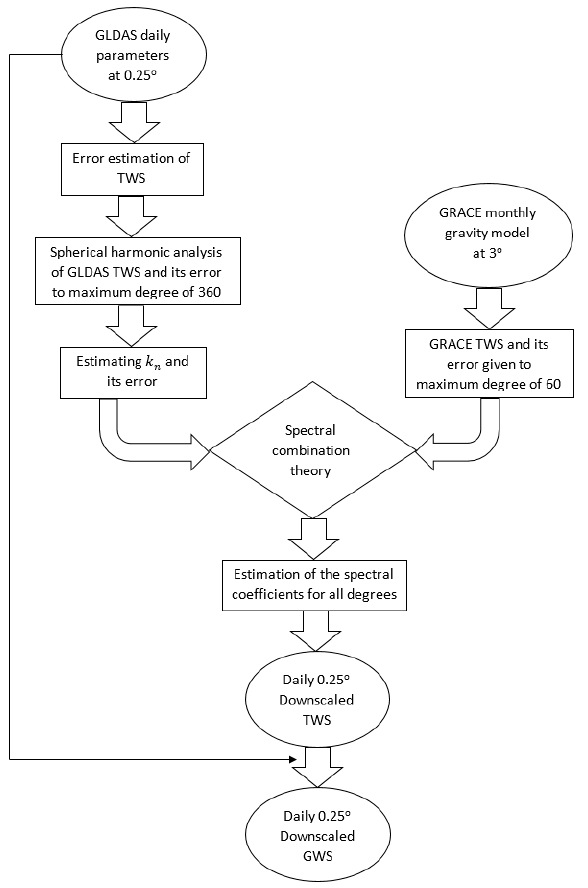
Figure 3. Technical flowchart for the spatiotemporal downscaling of GRACE TWS and GWS changes. Equation (4) can be used for estimating the error of the TWS in monthly or daily